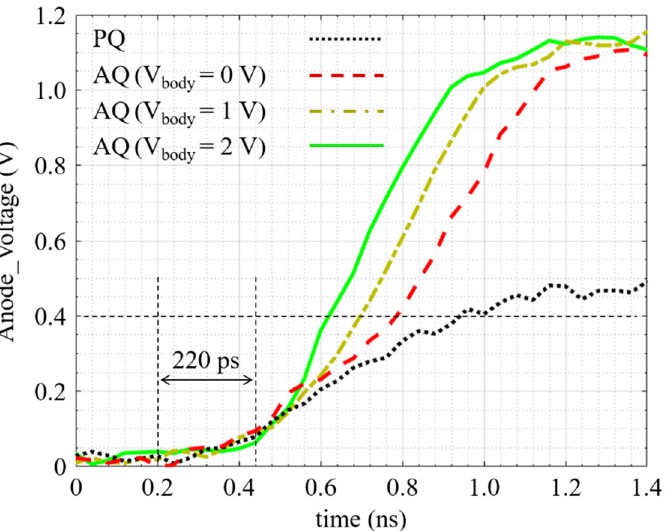
Figure 10. Anode voltage transient in the PQ and the AQ when an avalanche occurs. The excess bias voltage is about 400 mV.